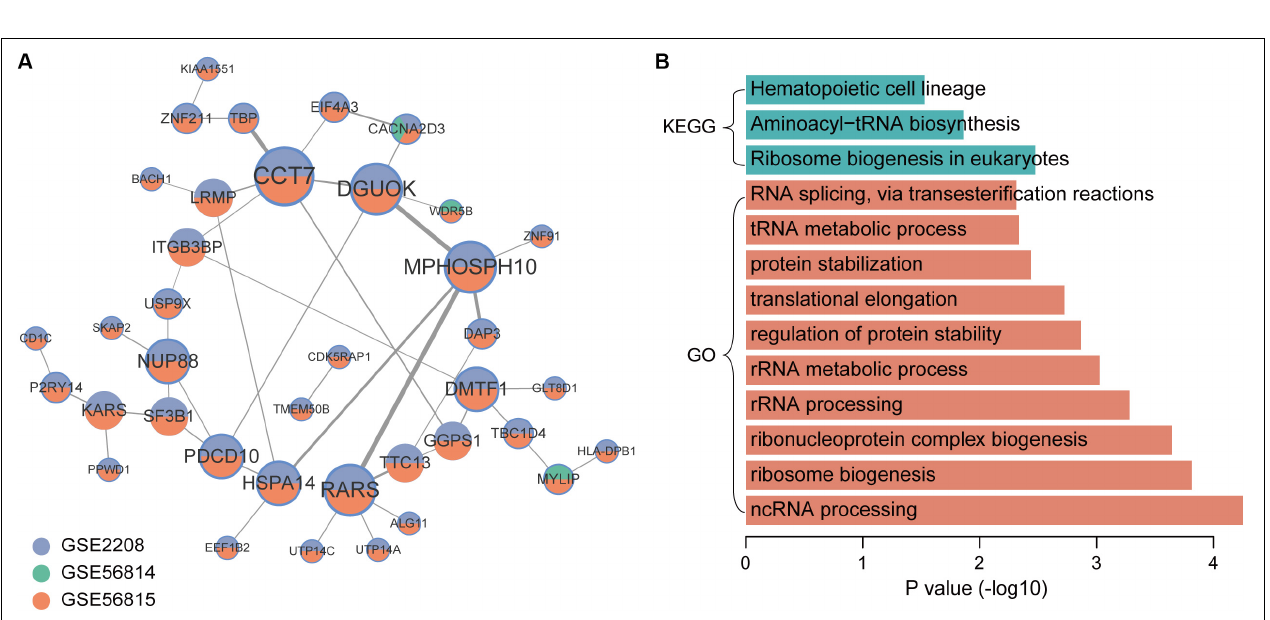
FIGURE 3 | Co-expression network and function enrichment analysis of genes that are consistently expressed in high BMD samples. (A) The gene co-expression network. Node size represents how many other genes interact with it. Node color indicates in which data sets it is up-regulated in high BMD samples. The darker the edge color, the greater the correlation coefficient. (B) GO and KEGG results of genes in network.